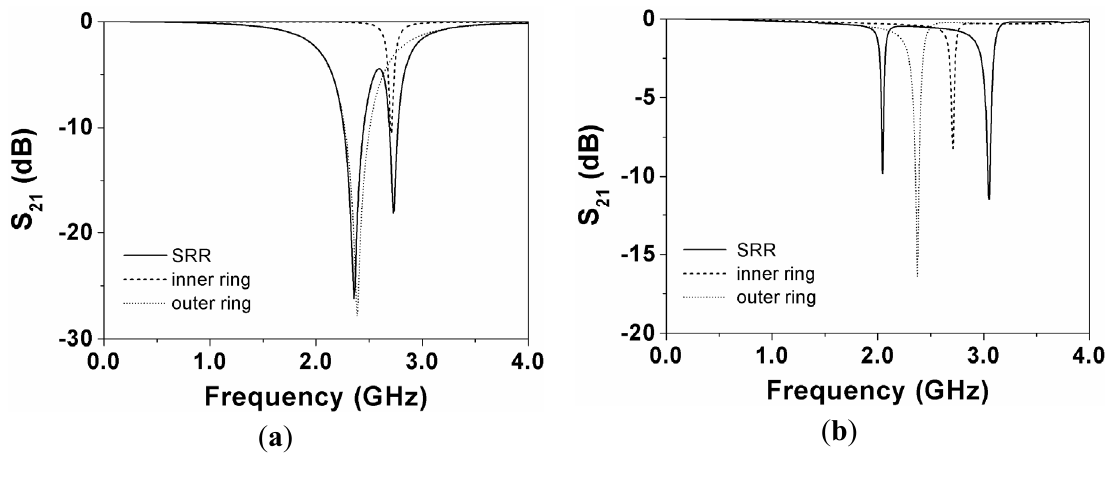
Figure 6. Simulated transmission coefficients of the structure of Figure 4(b) by laterally displacing 0.5 mm the SRR, and by considering only the inner or the outer ring (also displaced); (a ) h = 127 µm and (b) h = 635